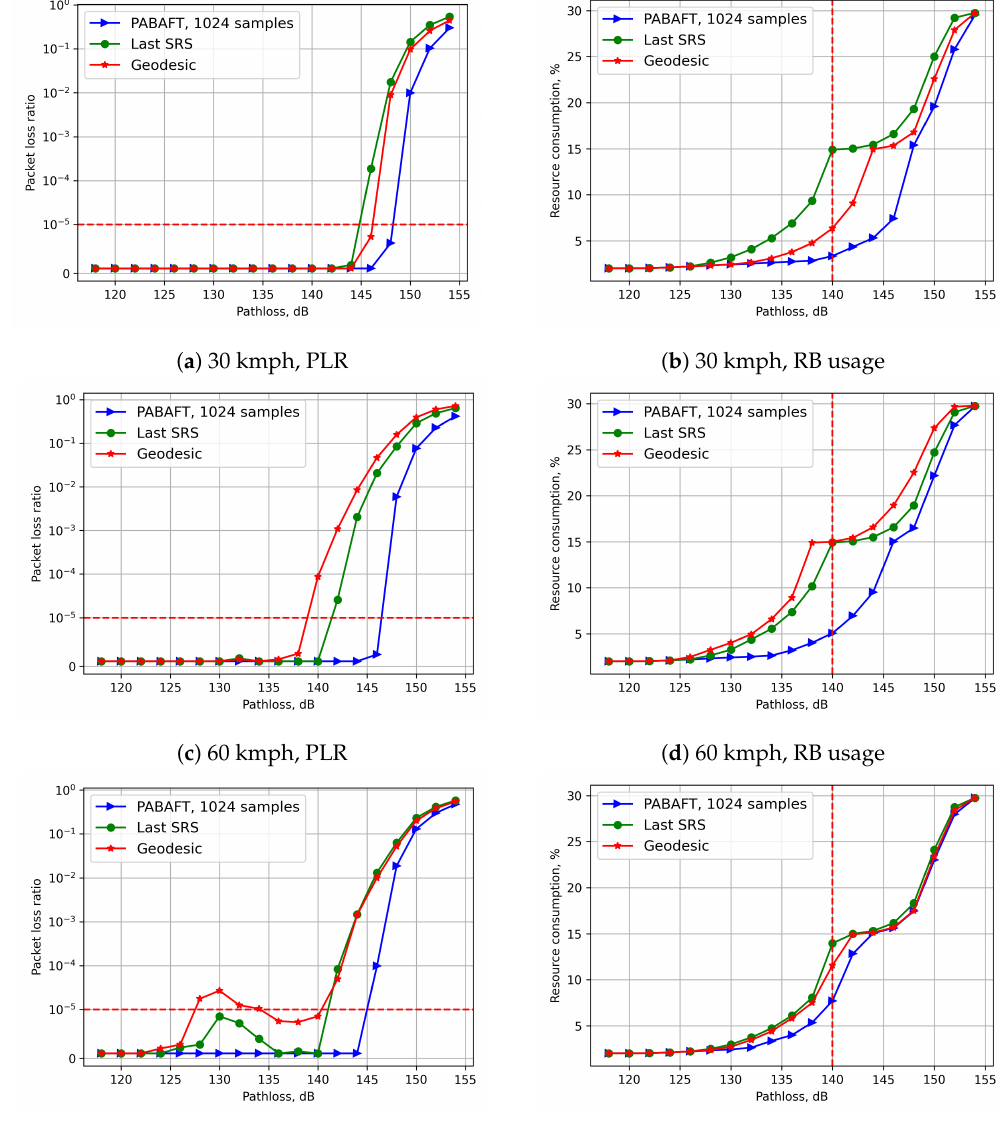
Figure 6. System-level